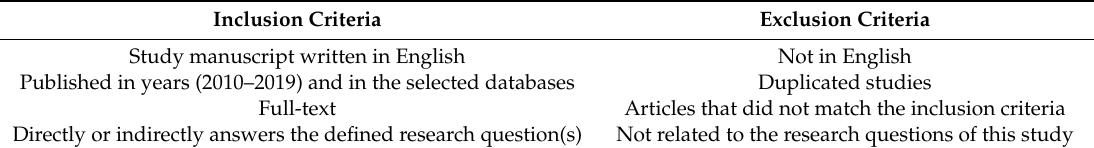
Table 2. Inclusion and exclusion